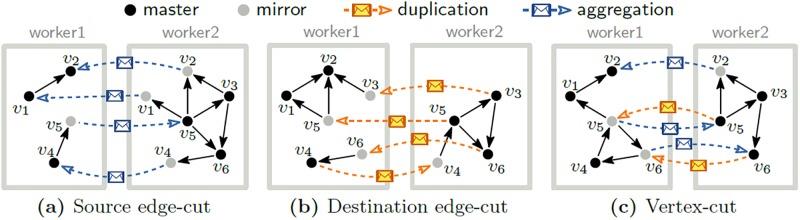
Examples of communication patterns according to graph partitioning methods: Edge-cut and vertex-cut.Workers exchange two types of messages: one for duplicating the value of a vertex to its mirrors and the other for copying the partially aggregated value of a mirror to its master. The sum of all exchanged messages is the communication cost. Note that the edge-cut methods also create the mirrors to aggregate duplication/aggregation messages from/to the same vertex even the edge-cut methods cut edges instead of vertices.